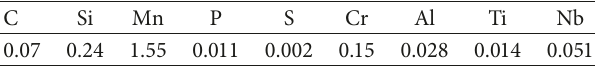
Table 1: Chemical composition of the X70 pipeline